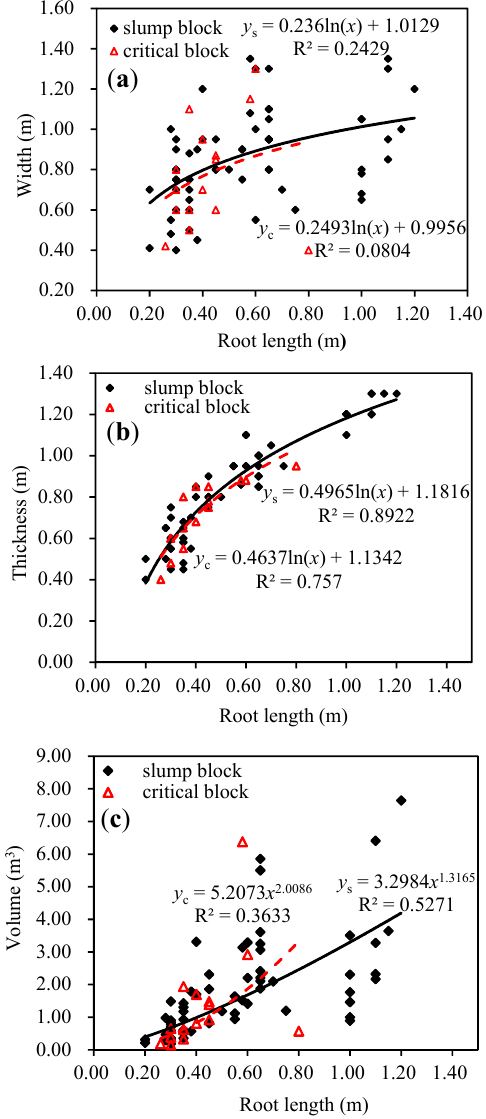
Figure 6. Relationship between root length and corresponding dimensions and volume of failed blocks. ( a ) block width; ( b ) block thickness; and ( c ) block volume.